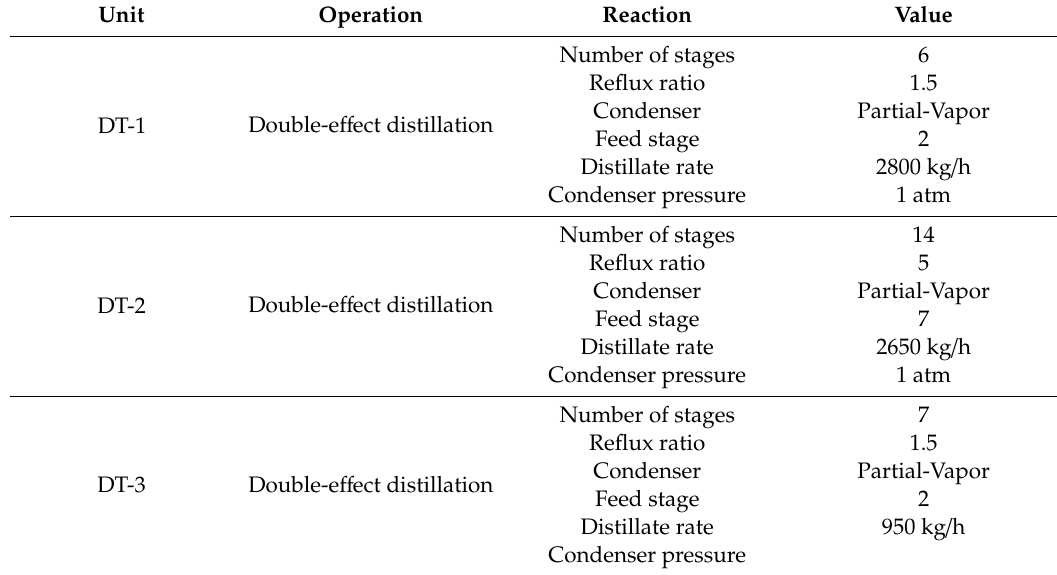
Table 6. Summary of the technical parameters of the main separation units in topology 2.